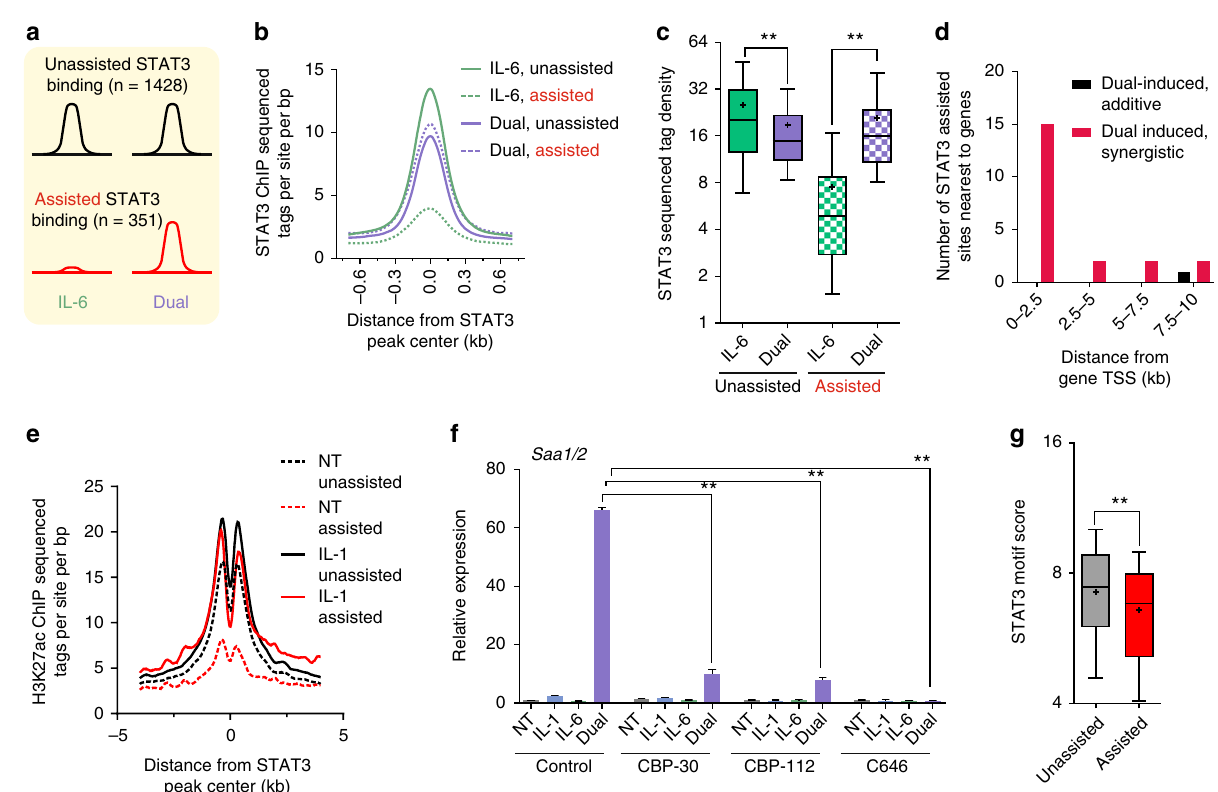
Fig. 4 IL-1 β primes a subset of enhancers and assists STAT3 loading onto them. a A scheme representing the fraction of STAT3 sites where no signi fi cant change in binding was detected between the IL-6 and dual conditions ( ‘ unassisted sites ’ ) and the fraction of sites where a signi fi cant (fold change ≥ 1.7, p - value ≤ 0.01, measured with DESeq) increase in binding was found in dual-treated cells compared to IL-6-treated cells ( ‘ assisted sites ’ ). b , c Assisted STAT3 binding sites only reach maximal binding in the dual treatment whereas STAT3 binding at unassisted sites is higher in IL-6-treated cells. d The number of assisted STAT3 binding sites nearest to either synergistic genes or to the same number of dual-induced genes with an additive fold change. Plotted as a function of distance from gene transcriptional start site (TSS, plotted in 2.5 kb bins). Only the nearest site is counted, second- or third-nearest sites are not shown. e H3K27ac ChIP-seq tag density in the vicinity of STAT3 binding sites in the non-treated vs IL-1 β conditions showing that IL-1 β activates enhancers where assisted sites reside. f Nascent RNA levels of Saa1/2 in primary hepatocytes pre-treated with p300/CBP inhibitors followed by indicated cytokine treatments. Representative experiment shown of at least three independent repeats. Error bars represent s.d. of three technical replicates. g Box plot depicting the STAT3 motif score in assisted vs unassisted sites. Double asterisks denote p -value ≤ 0.01 as determined by an